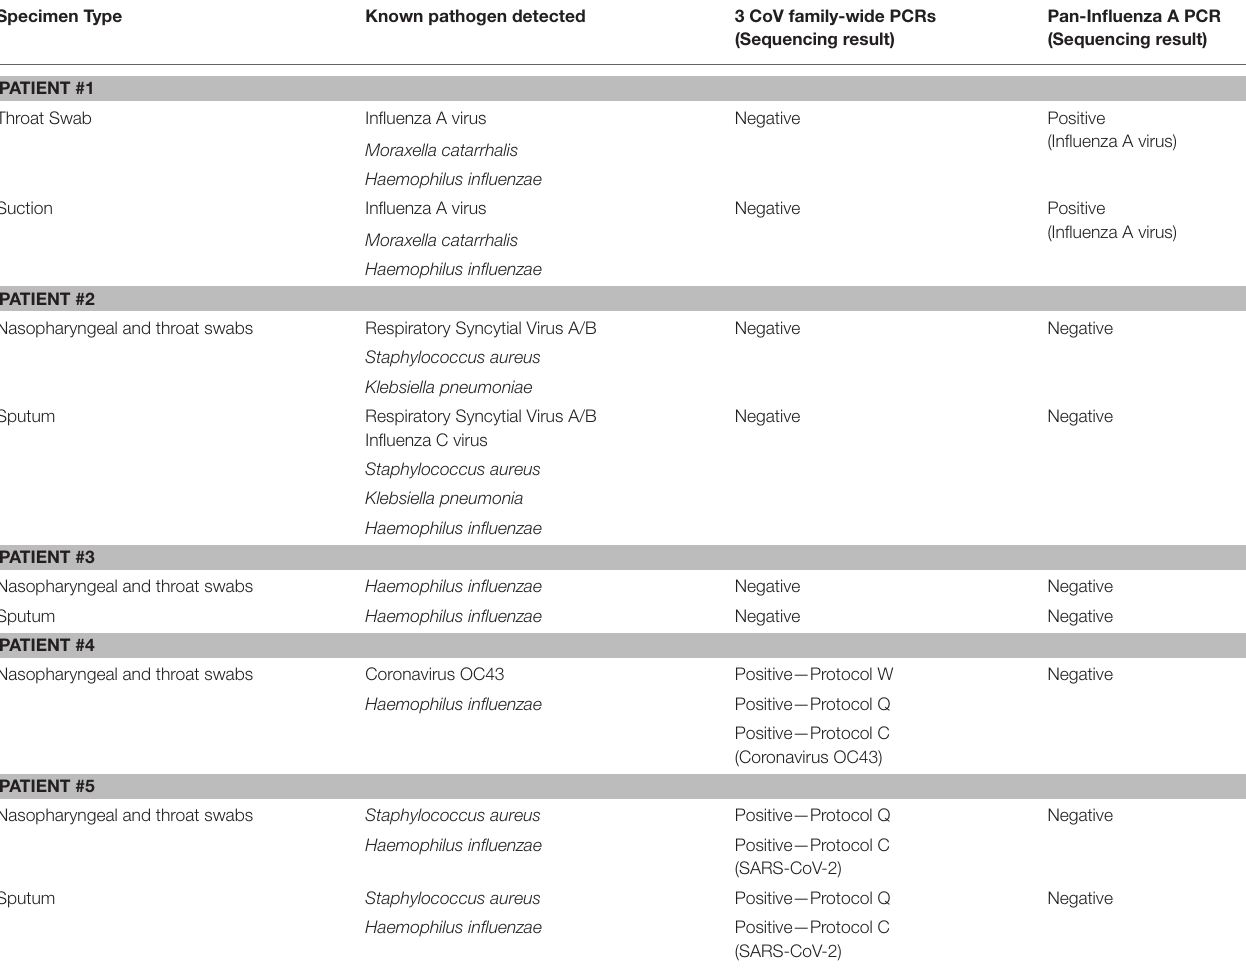
TABLE 1 | PCR results of 33 known respiratory pathogen and family-wide PCR detection for 5 PUIs identified. Specimen